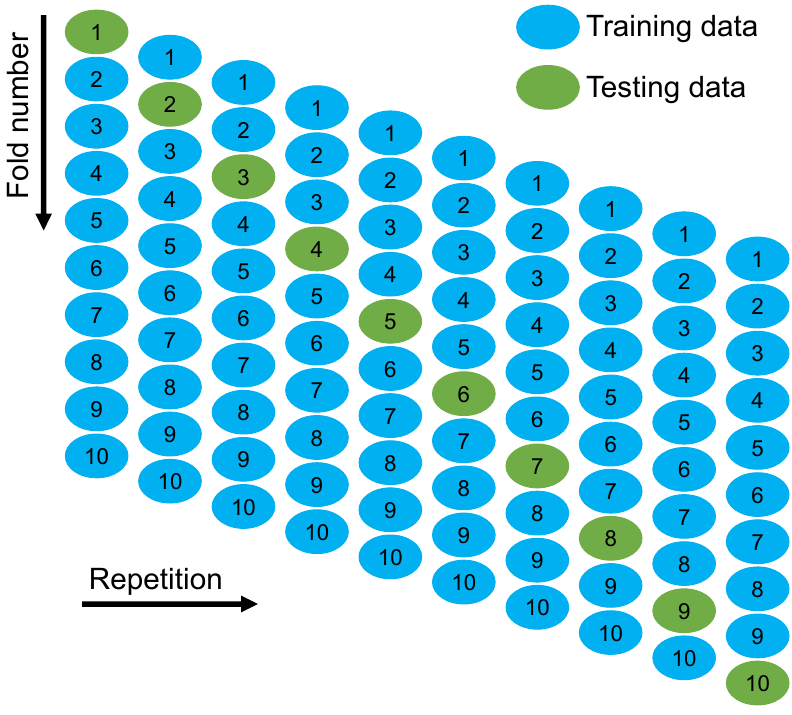
Figure 10. K-fold cross-validation procedure.